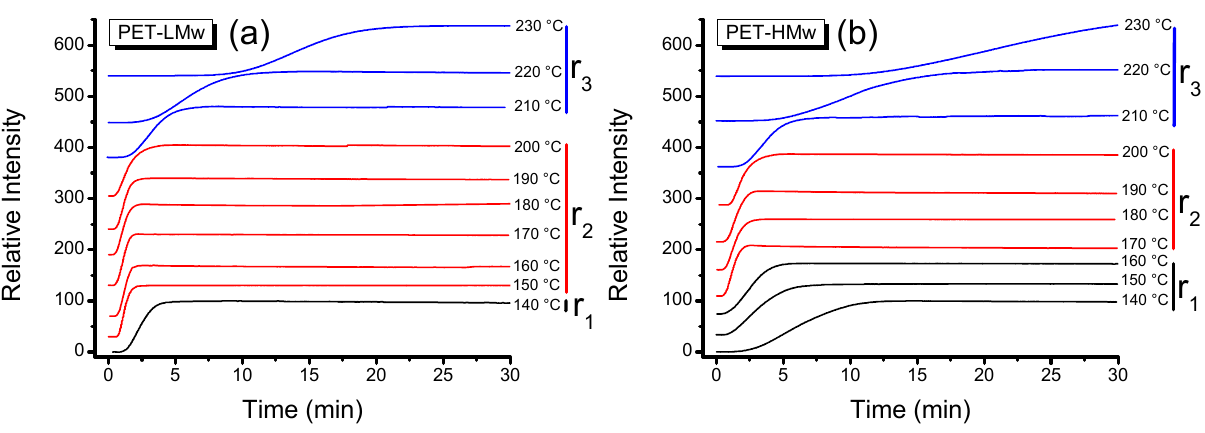
Figure 1. Evolution of transmitted depolarized light intensity during the isothermal crystallization (30 min) of PET samples at different temperatures: ( a ) PET-LMw; and ( b )